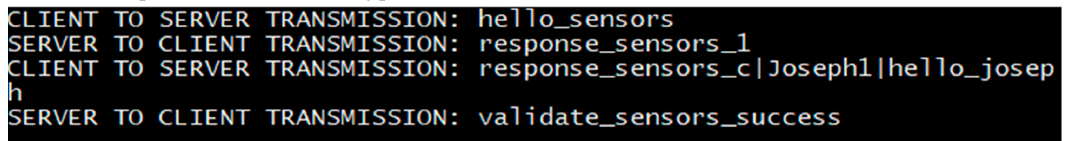
Figure 15. Intercepted data from client and server using a simple hash comparison login—hashing on the server side. Sensors 2020 , 20 , x FOR PEER REVIEW